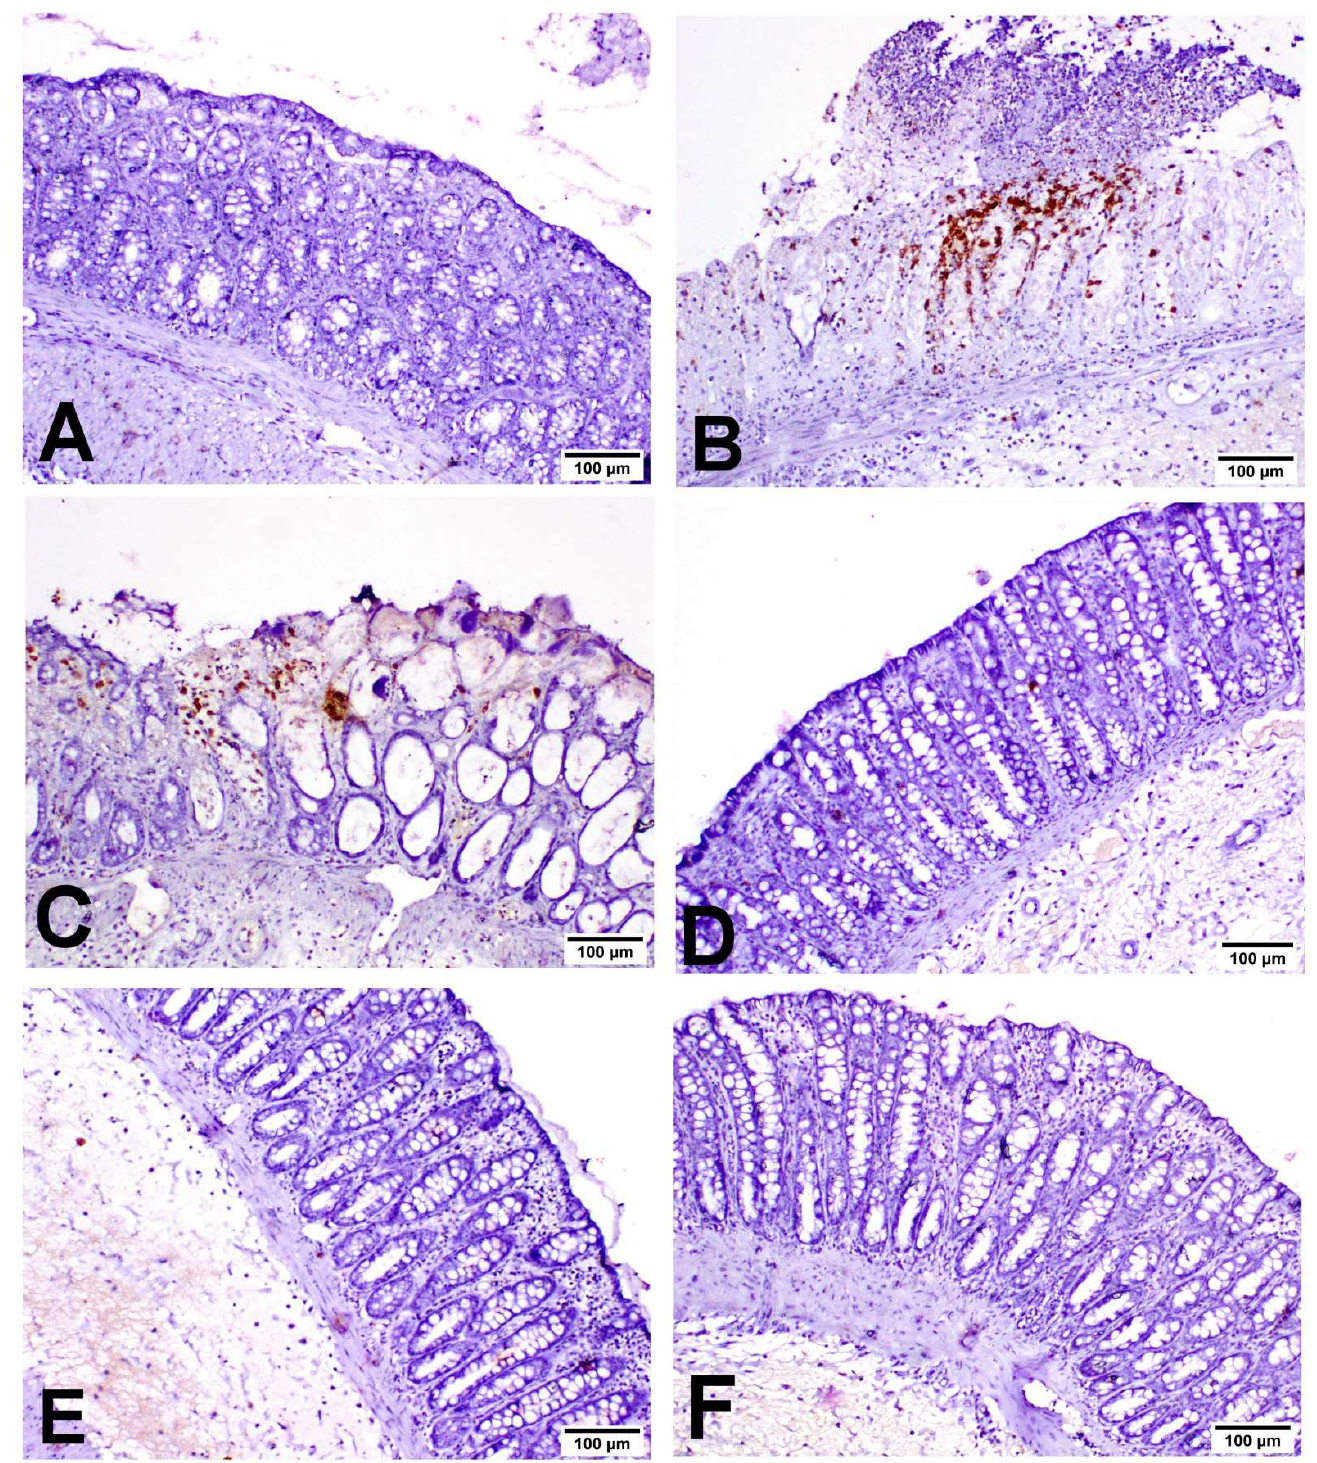
Figure 5. Immunohistochemistry of INOS expression in the colon of the different groups: ( A ) NC group; ( B ) UC group; ( C ) MIC-20 group; ( D ) MIC-40 group; ( E ) SSZ-100 group; ( F ) MIC + SSZ group.